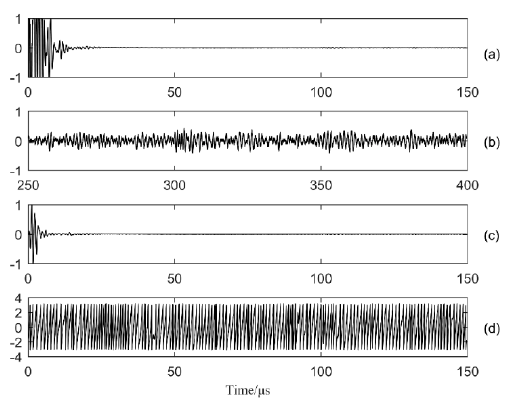
Figure 4. Time traces for i = 16, j = 16 in plate B: ( a ) directly captured signal response; ( b ) diffuse full matrix, d ij ( t ) ; ( c) hybrid full matrix signal, m ij ( t ) ; and ( d ) instantaneous phase, ϕ ij ( t )